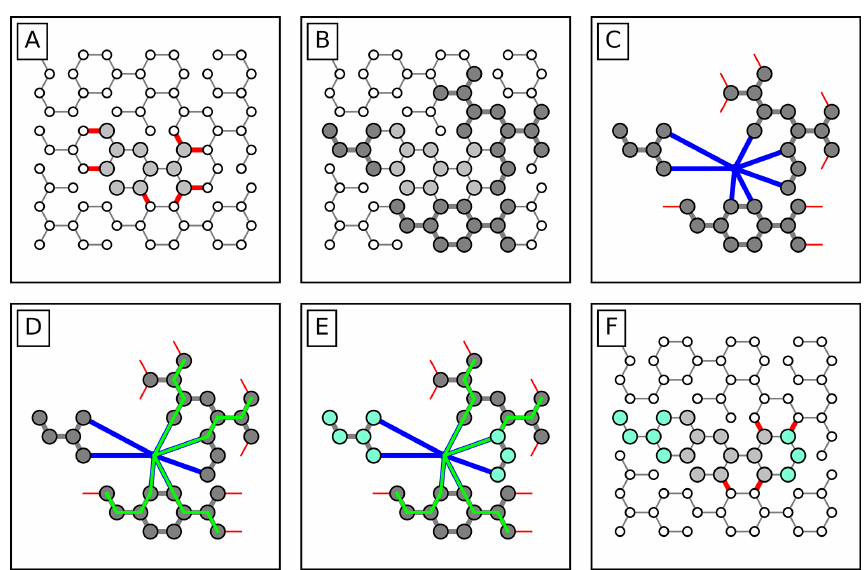
Figure 10. Conceptual steps made by the hybrid variator to reduce the number of boundaries of a specific DMA by assimilation certain nearby nodes. The individual steps are explained in more detail in the text.